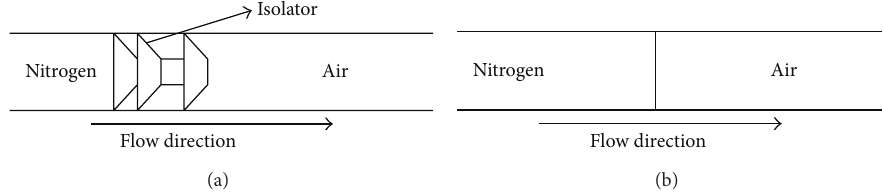
Figure 1: Schematic diagram of nitrogen replacement: (a) with isolator; (b) without